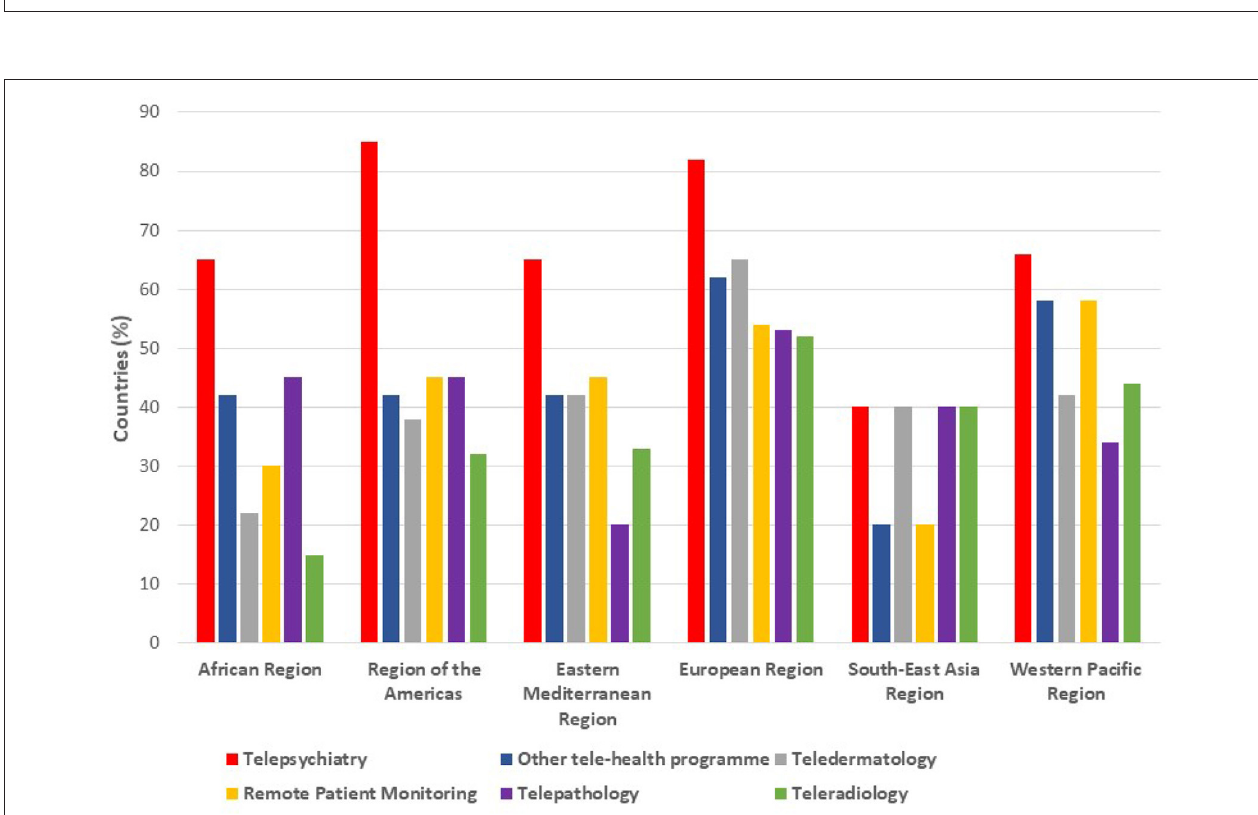
FIGURE 5 | Challenges in implementing telehealth programmes to support Universal Health Coverage (UHC), evaluated by the level of importance.